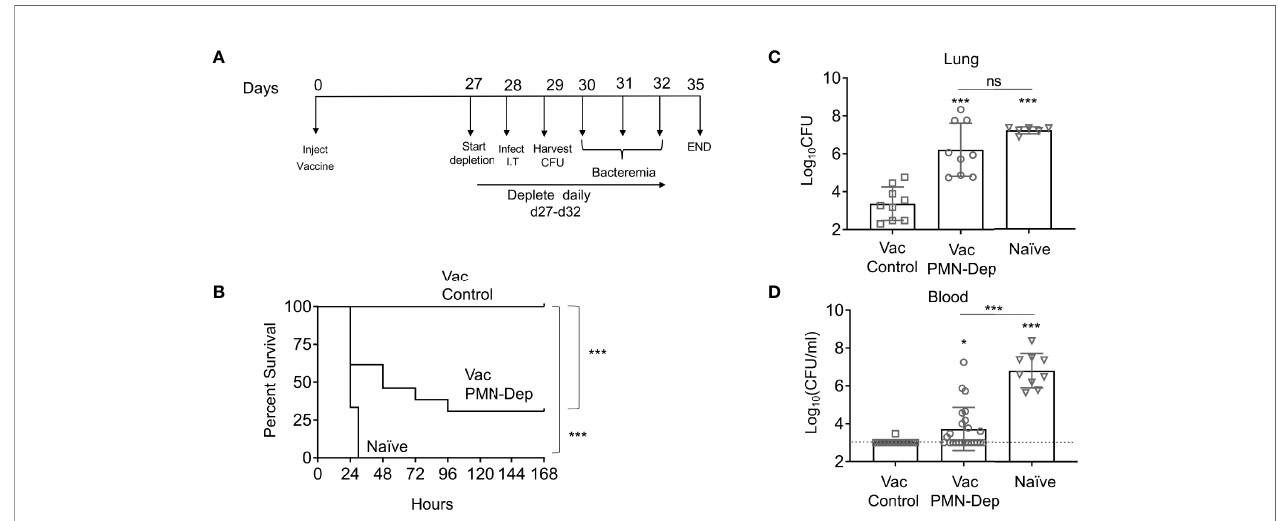
FIGURE 1 | PMNs are required for protection of PCV immunized young hosts at the time of bacterial challenge. Young C57BL/6 female mice were mock treated (naïve) or administered 50 m l of Prevnar-13 via intramuscular injections to the hind legs (vaccinated). Four weeks following vaccination mice were challenged i.t. with 1x10 7 CFU S. pneumoniae TIGR4. To deplete PMNs prior to infection, mice were injected i.p. with anti-Ly6G antibodies (IA8) or isotype control at days -1, 0, and +1 to +4 with respect to infection as outlined in (A) . (B) Mice were then monitored for survival. (B) Data were pooled from three experiments with 14 mice per group. Signi fi cant differences were determined using the Log-Rank (Mantel-Cox) test. Bacterial burden in the lung (C) and blood (D) were also assessed 1 day post infection. (C, D) Data were pooled from three separate experiments with n = 9 mice per group. Each square indicates an individual mouse. *, denotes signi fi cant differences by One-way ANOVA followed by Tukey ’ s multiple comparisons test. * denotes p < 0.05 and *** denotes p < 0.001 . ns denotes not signi fi